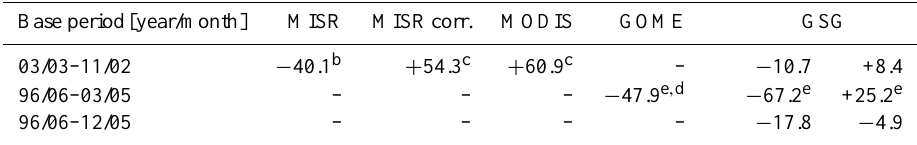
Table 3. Overview of trends in cloud height [mdecade − 1 ] a . Trends derived from the GSG data set are given with (left column) and without (right column) ENSO, that has been filtered masking any data within the Niño 3.4 climate index box 170–120 ◦ W, 5 ◦ N–5 ◦ S